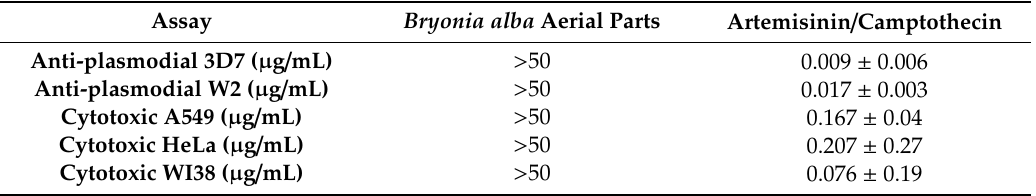
Table 4. Assessment of the cytotoxicity and of the anti-plasmodial activity of the aerial parts of Bryonia alba L. (IC 50 µ g /